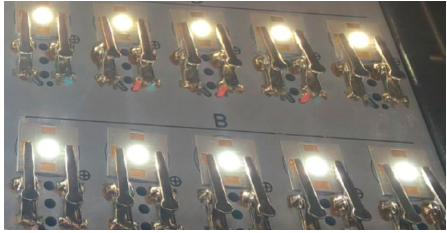
Figure 3. The CSP LED samples under 120 mA during the step-stress accelerated degradation test (SSADT) process. (Top: 4000 °K samples; Bottom: 5000 °K samples).